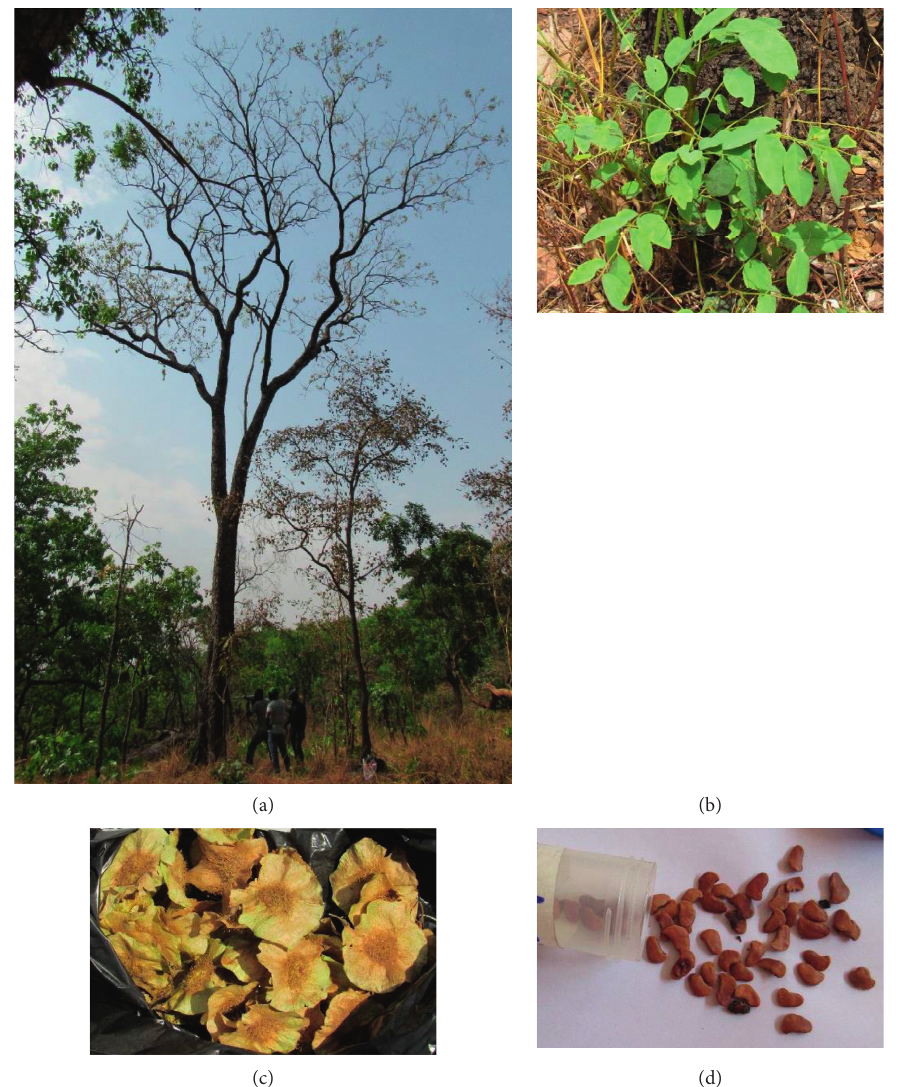
Figure 2: Pterocarpus erinaceus tree (a), leaves (b),fruits (c),and seeds (d) (photo: Johnson B. N.). Table 2: Number of trees sampled according to the site.